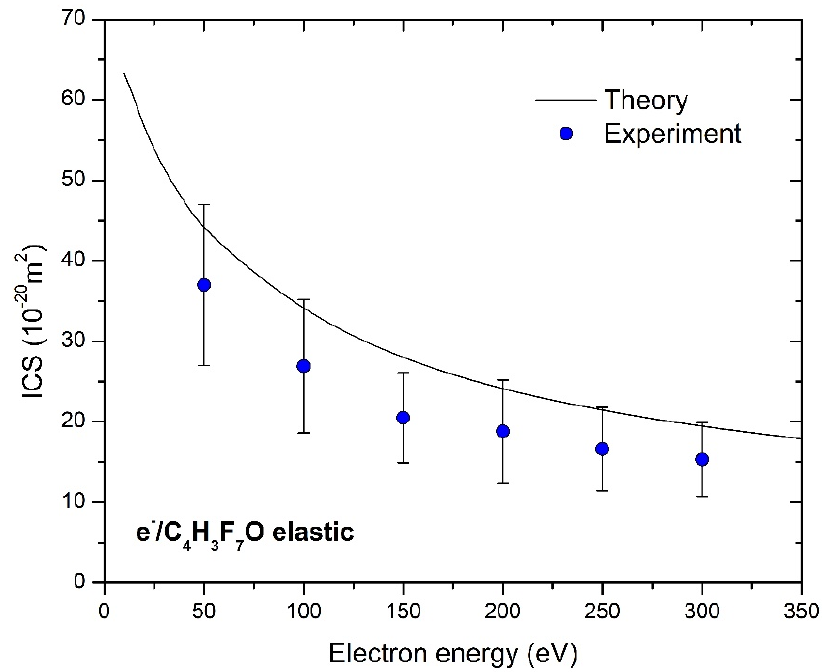
Figure 4. Integral cross-section for elastic electron collision with sevoflurane molecule in the energy range from 10 eV to 350 eV. Experiment (blue circles) and theory (solid black line) are presented.